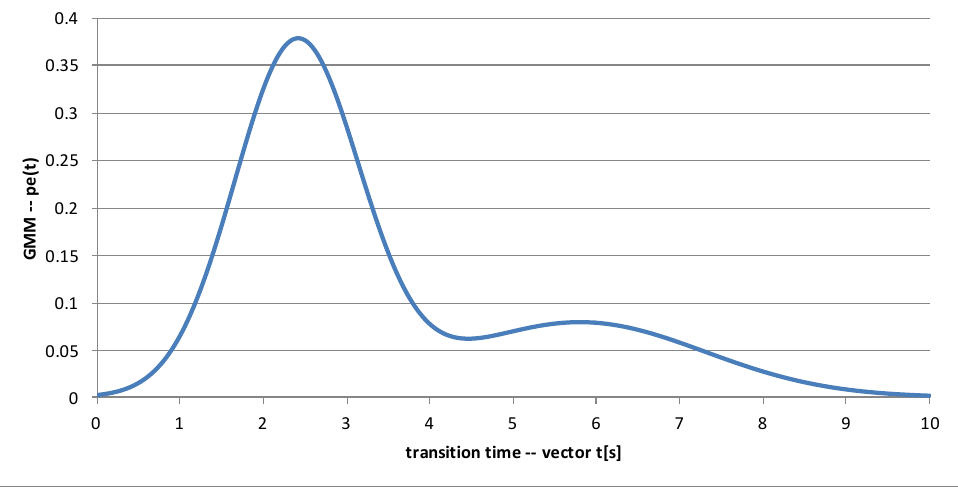
Figure 14. GMM after iteration k = 15 of the EM